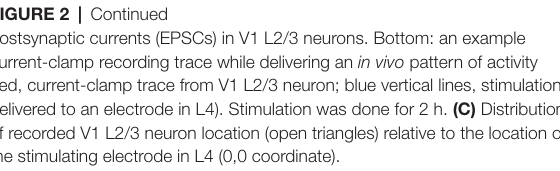
FIGURE 2 | Continued postsynaptic currents (EPSCs) in V1 L2/3 neurons. Bottom: an